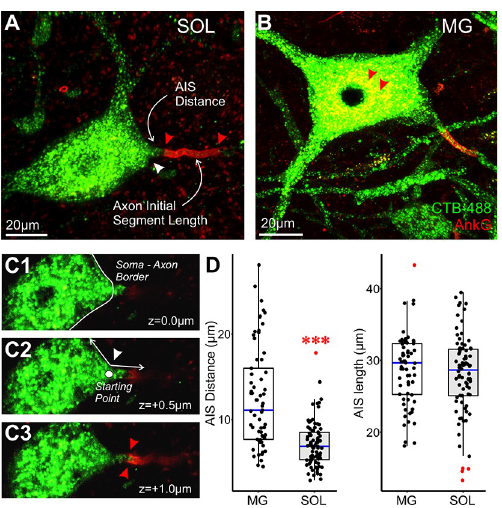
Fig 1. AIS distance differs in motor pools distinguished by their activity patterns. (A, C) MG and SOL motoneurons pre-labeled with the retrograde tracer cholera toxin subunit B conjugated to Alexa fluor 488 (CTB) and immunolabeled for ankyrin-G (AnkG), a marker for the AIS. Our definition of AIS distance (AIS d ) and AIS length (AIS ) is identified by white arrows and corresponding text in panel C. (A) white arrow indicates the start of axon from l soma and first red arrow indicates initiation of AIS. The two red arrowheads identify the start and end of the AIS. The two red arrowheads in C point to lipofuscin granules that is common in mature motoneurons. (B1-B3) Single z-steps through a confocal image stack. (B1) Initial indication of the axon emerging from the soma. The soma-axon boundary is indicated by the solid white line. (B2) The white lines were used to determine the apex of the angle in which the axon emerged from the soma and is marked by a white dot. This was used as the starting point for measuring distance. (B3) The red arrows indicate the start of the AIS as defined by expression of AnkG. (D) Box and whisker plots of AIS d and compared between MG (n = 65) and SOL (n = 82) motoneurons. Blue horizontal line inside the plot represents AIS l the median value. Black dots represent a single data point and red dots are designated outliers. Based on the distribution of these data, a nonparametric test (Mann-Whitney U test) was used for an initial statistical comparison (AIS : p < 0.001, AIS : p = d l